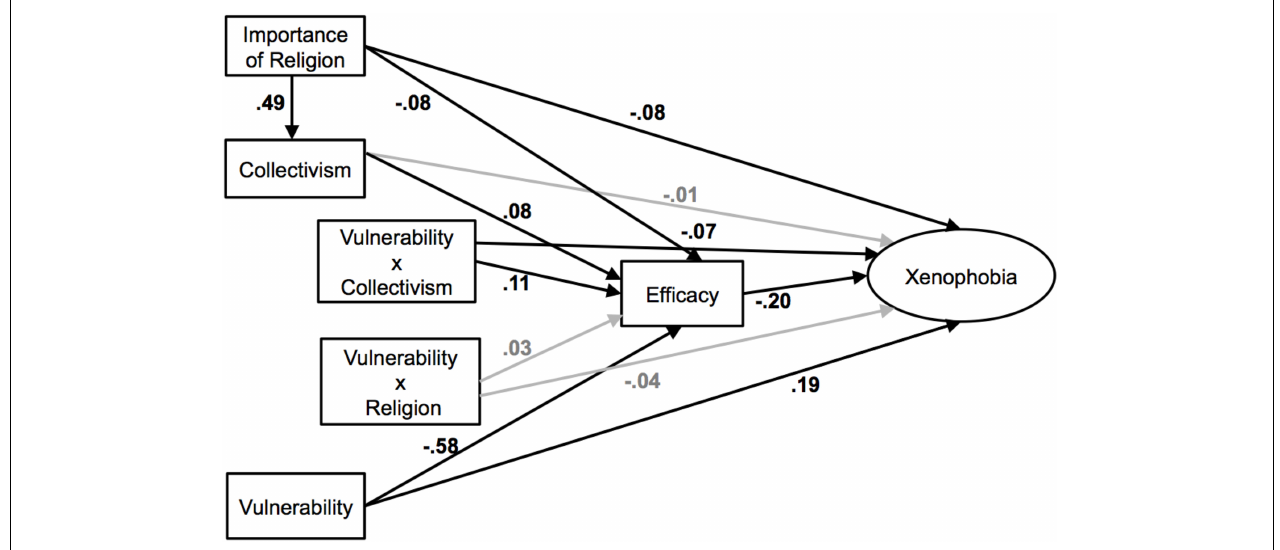
FIGURE 3 | Structural equation model examining whether importance of religion moderates the association between perceived vulnerability and xenophobia through collectivism. The values shown are standardized path coefficients; black lines represent significant paths and gray lines represent non-significant paths ( p >